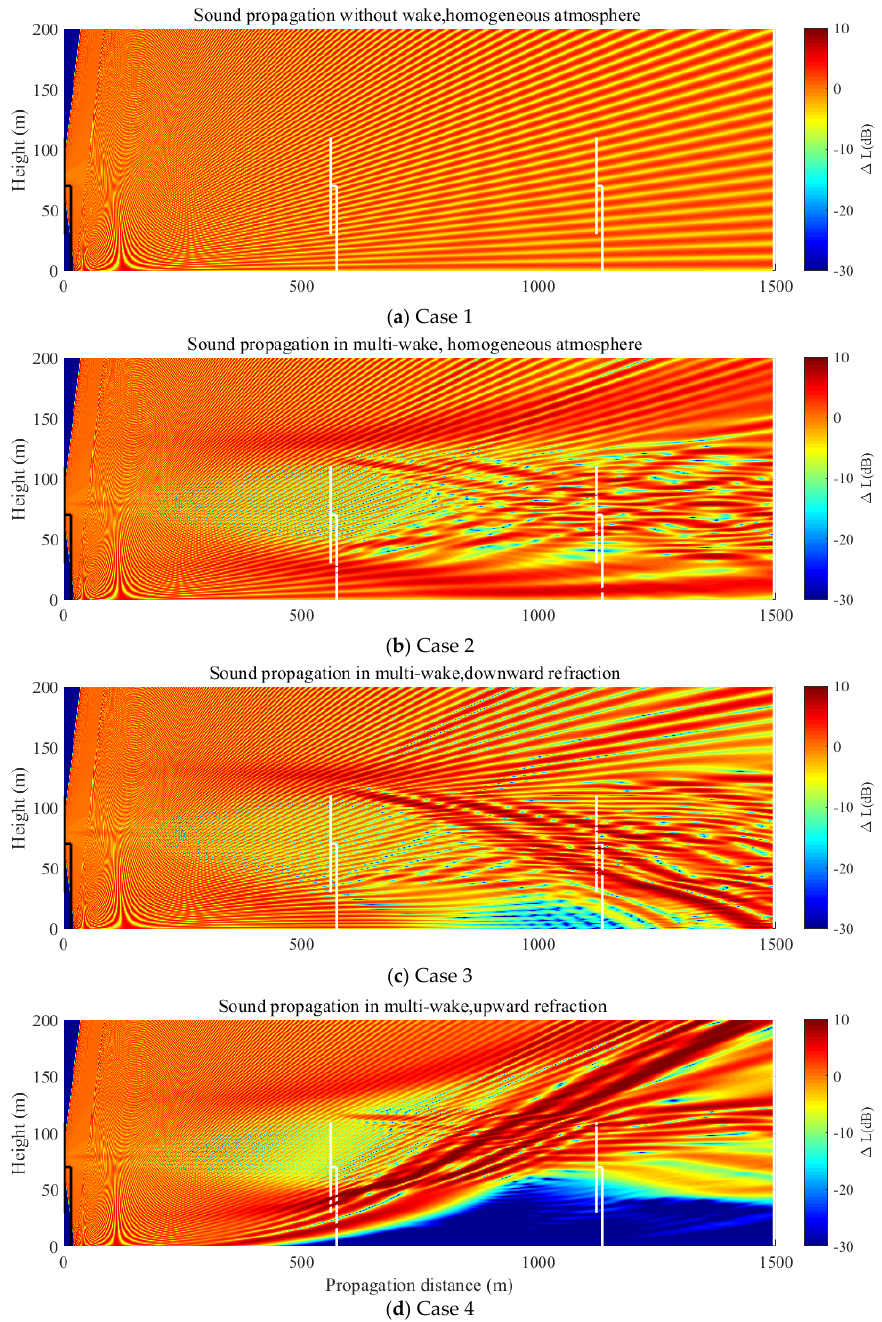
Figure 13. ANPropagation from the first ANSource: ( a ) Case 1, homogeneous atmospheric condition, no wake effect; ( b ) Case 2, homogeneous atmospheric condition with multi-wakes; ( c ) Case 3, downward refraction and multi-wakes; ( d ) Case 4, upward refraction and multi-wakes.